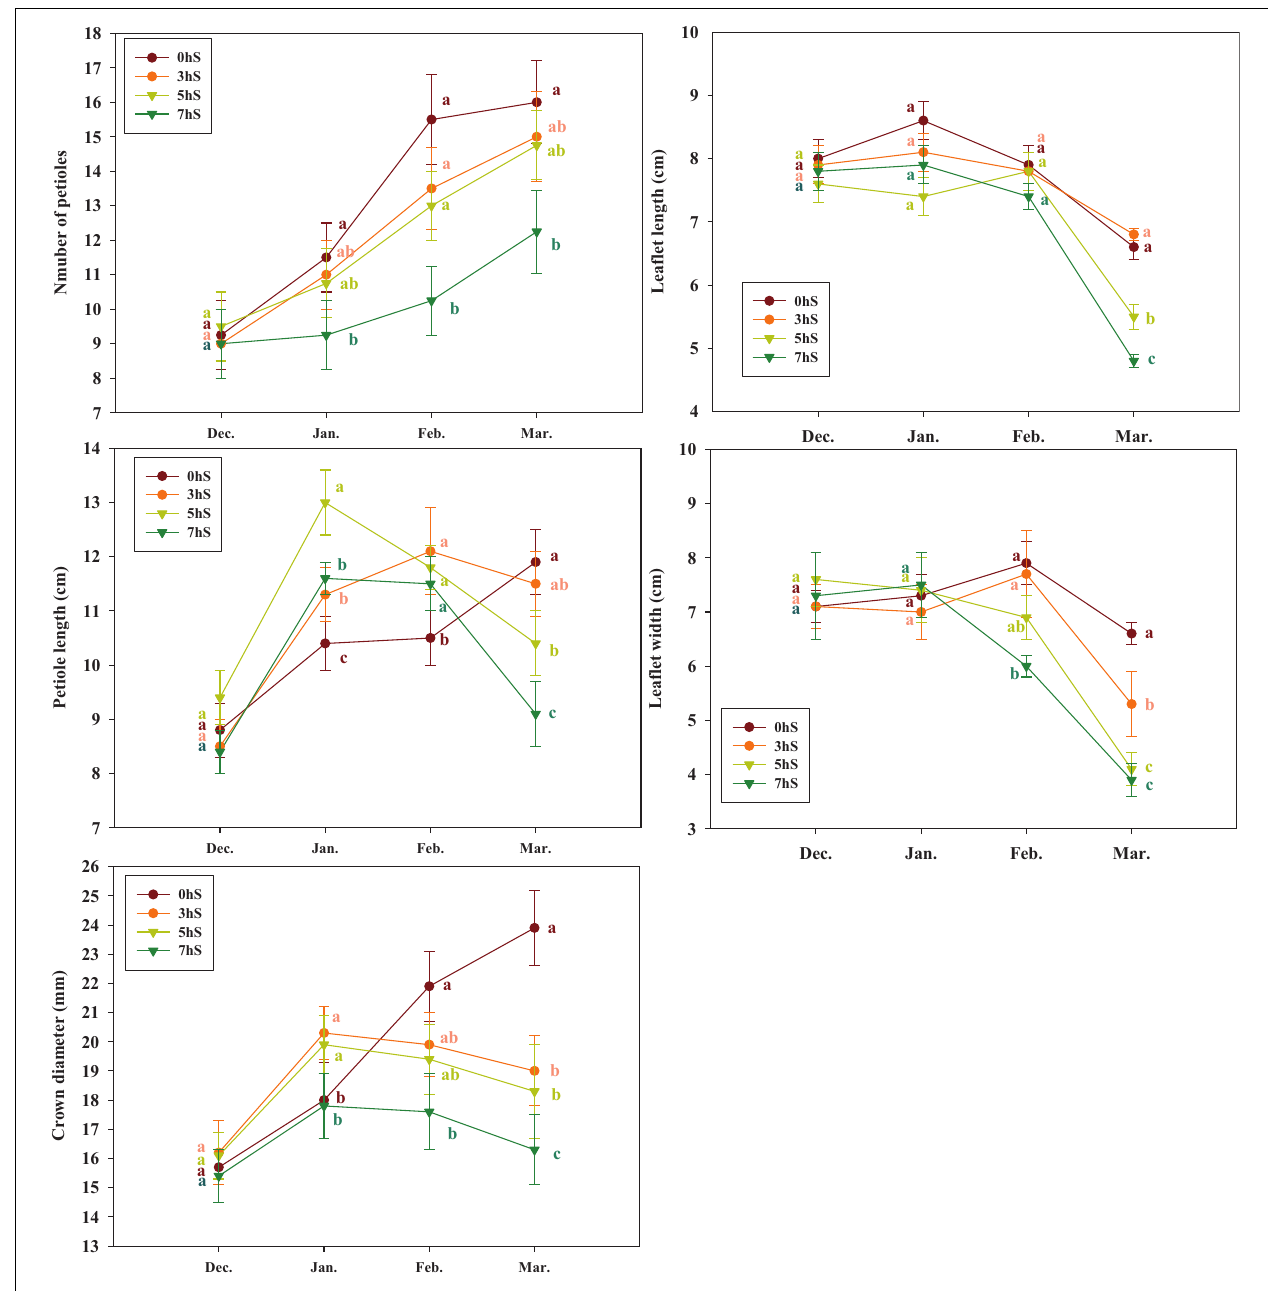
FIGURE 5 | Growth of aboveground part of the strawberry ( Fragaria × ananassa ) plants grown under various light intensity conditions in a smart greenhouse. Vertical bars represent standard deviations. Different letters above the bars indicate significant differences among treatments (Duncan’s multiple range test, p < 0.05, n = 3). 0 hS, non-shading treatment (control); 3 hS, three hours of shading until 10:00; 5 hS, five hours of shading until 12:00; 7 hS, seven hours of shading until 14:00.